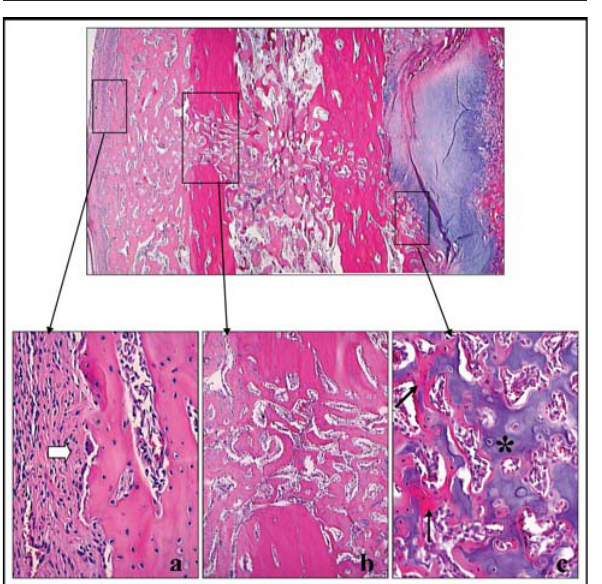
FIGURE 2 - Fracture site of the treated forelimb at 30 days postoperative. Observe the presence of bone callus involving the fracture edges (general aspect) and the union of the cortical bone with bone tissue more compact and mature in relation to control limb (b). The region of the bone callus facing the epidermis (c) as well as the bone callus facing the ulna (a) shows bone tissue (arrows) in reabsorption by osteoclasts (large arrows). HE, x10, x200, x40 and